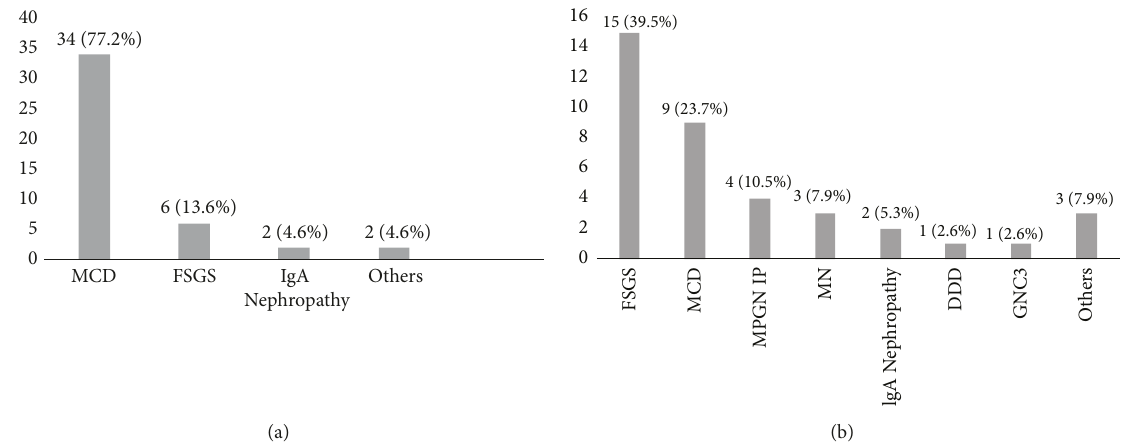
Figure3:Specificentityaccordingtocorticosteroidsresponse.(a)Steroid-dependentorfrequentlyrelapsingnephroticsyndrome;(b)steroid- resistant nephrotic syndrome; MCD: minimal change disease; FSGS: focal segmental glomerulosclerosis; MPGN IP: membranoproliferative glomerulonephritis immunoglobulin positive; MN: membranous nephropathy; DDD: dense deposit disease; C3GN: C3 glomerulonephritis.